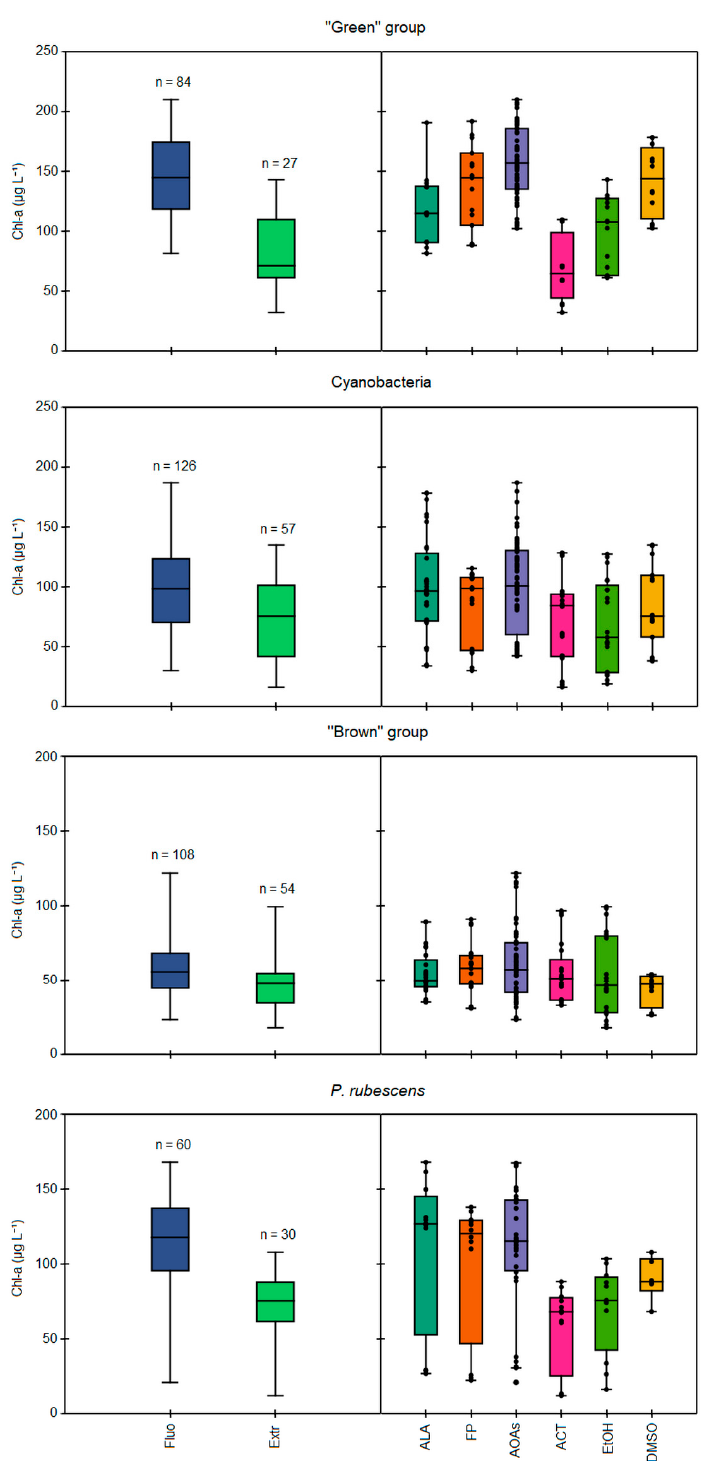
Figure 1. Comparison of total Chl -a concentrations ( μ g L − 1 ) during the 23 simultaneous Chl -a detec- tion tests, as measured by in vivo fluorescence and through extraction methods (on the left), or spe- cifically according to the different models of spectrofluorometers and extraction methods (on the right), based on the target algal group, i.e., “green” group, Cyanobacteria, “brown” group, and P. rubescens . Fluo = all measurements performed by in vivo fluorescence, Extr = all measurements of extraction methods, ALA = AlgaeLabAnalyser, FP = FluoroProbe, AOAs = four models of AlgaeOn- lineAnalyser, ACT = extraction with 90% acetone, EtOH = extraction with 90% ethanol, DMSO = extraction with dimethyl sulfoxide.